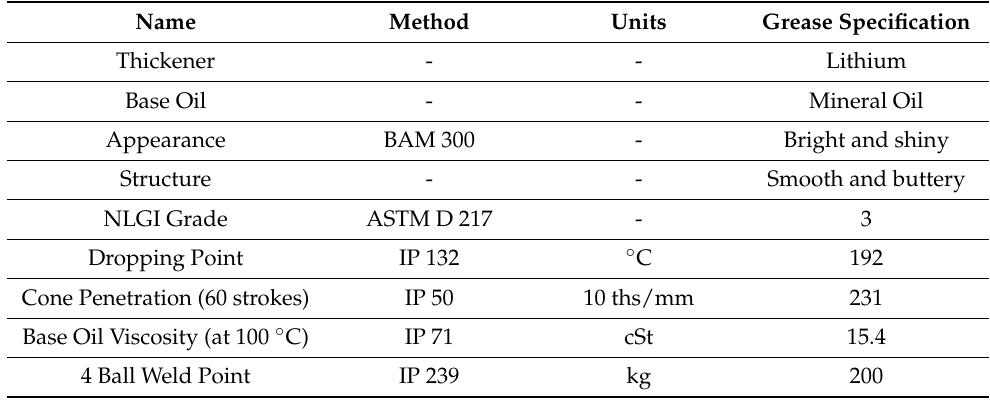
Figure 4. The contaminating materials considered for the experimental work ( a ) Babool Leaves (Acacia Nilotica), ( b ) Sand, and ( c ) Grease. Table 7. Grease Specification [34].